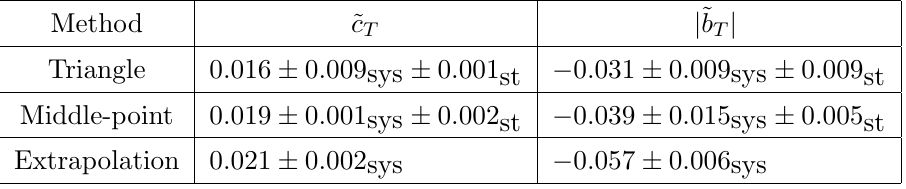
Table 1 . Estimation of the triple